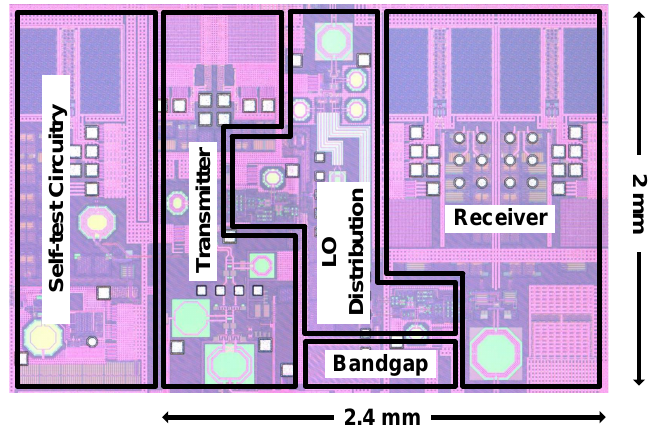
Figure 20. Micrograph of the implemented CMOS transceiver chip.